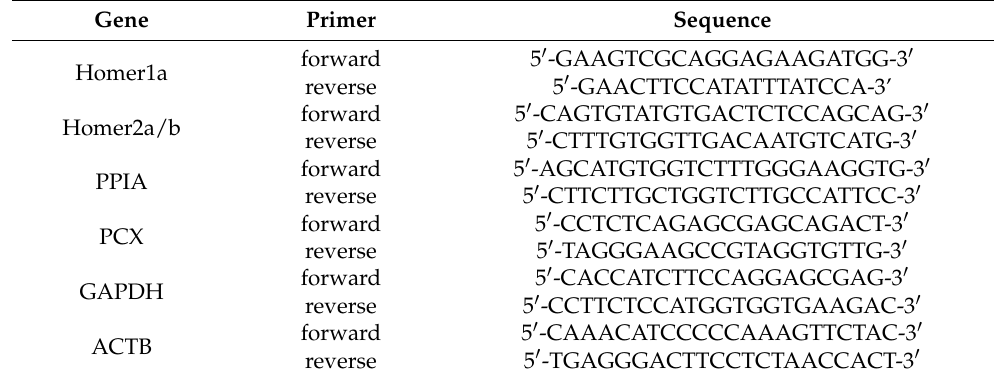
Table 1. Primer sequences for mouse tissue qPCR